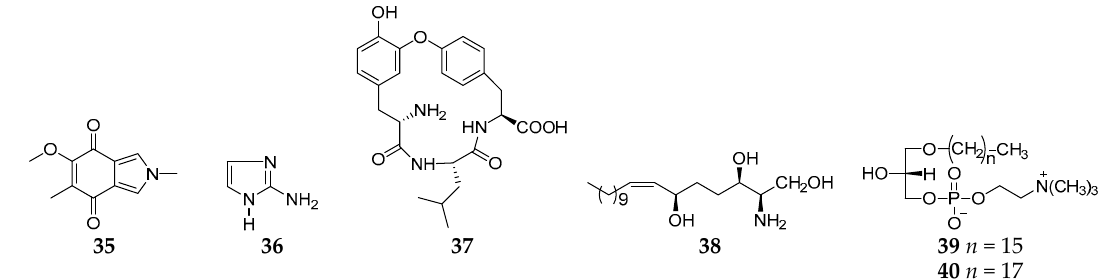
Figure 4. Other alkaloids derivatives 35 – 40 from the subgenus Reniera.